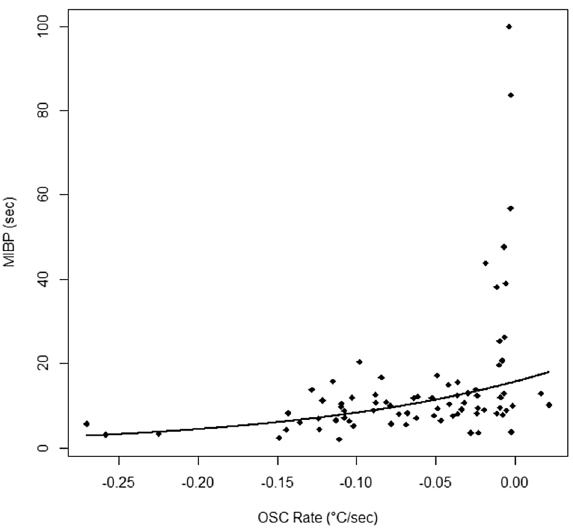
Figure 4. Exponential model of the MIBP as a function of OSC rate across all